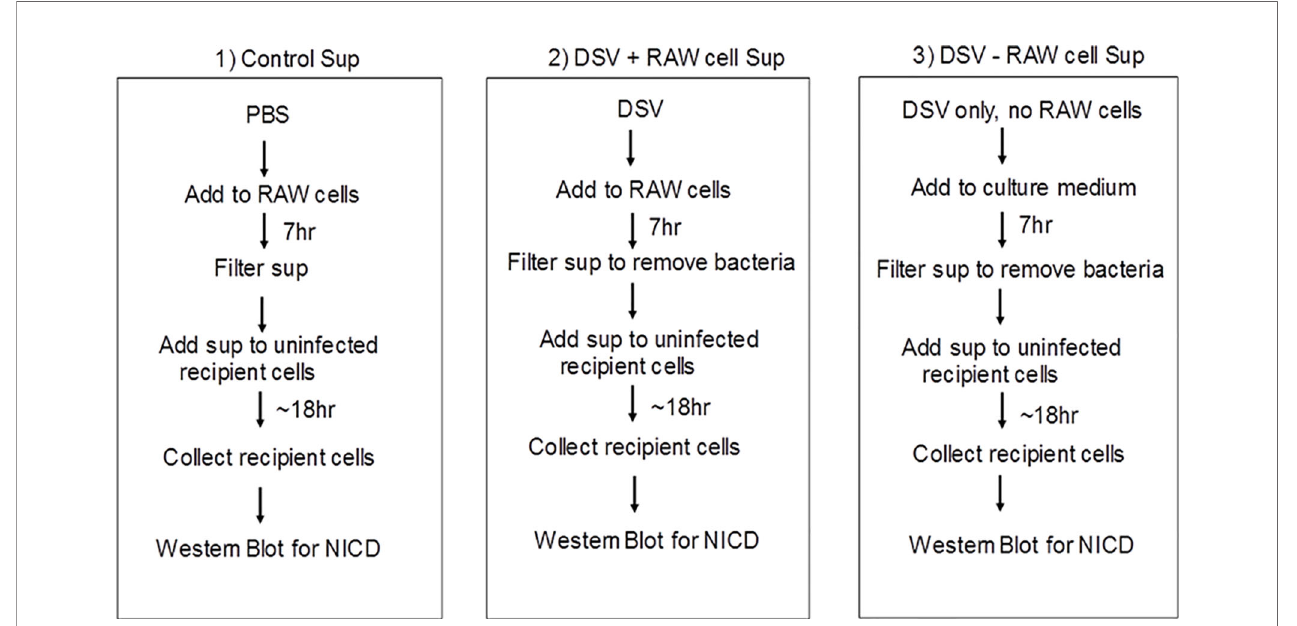
FIGURE 6 | Schematic representation of the methodology for testing paracrine effect of soluble factors in DSV-infected cells on uninfected recipient